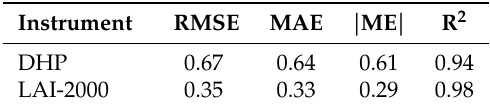
Table 2. Statistical indicators (Root-mean-squared error, RMSE; mean absolute error, MAE; absolute value of the mean error, | ME | ; and the coefficient of determination, R 2 ) between PocketLAI estimated values and classical instruments (DHP and